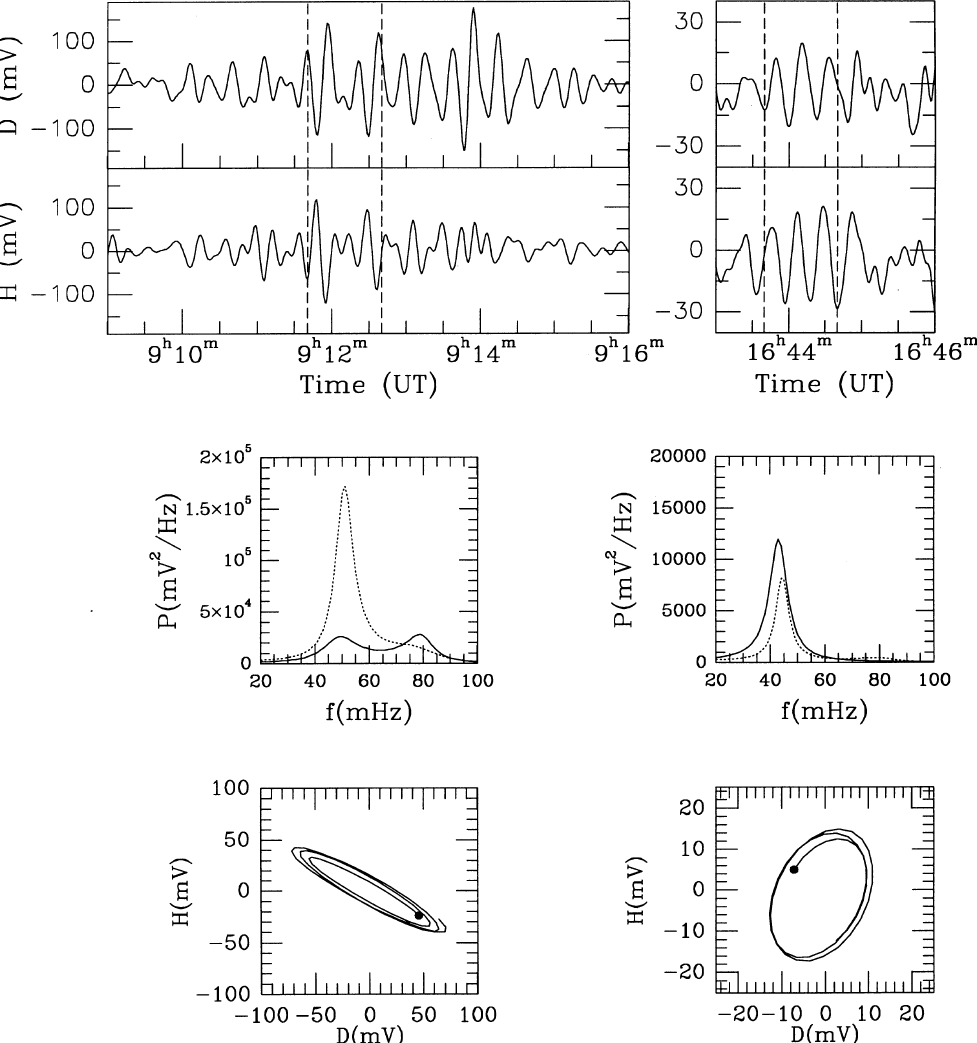
corresponding upper panel by dashed vertical lines ) filtered at the peak frequency (51 (cid:139) 5 mHz and 44 (cid:139) 5 mHz); the black dot indicates the